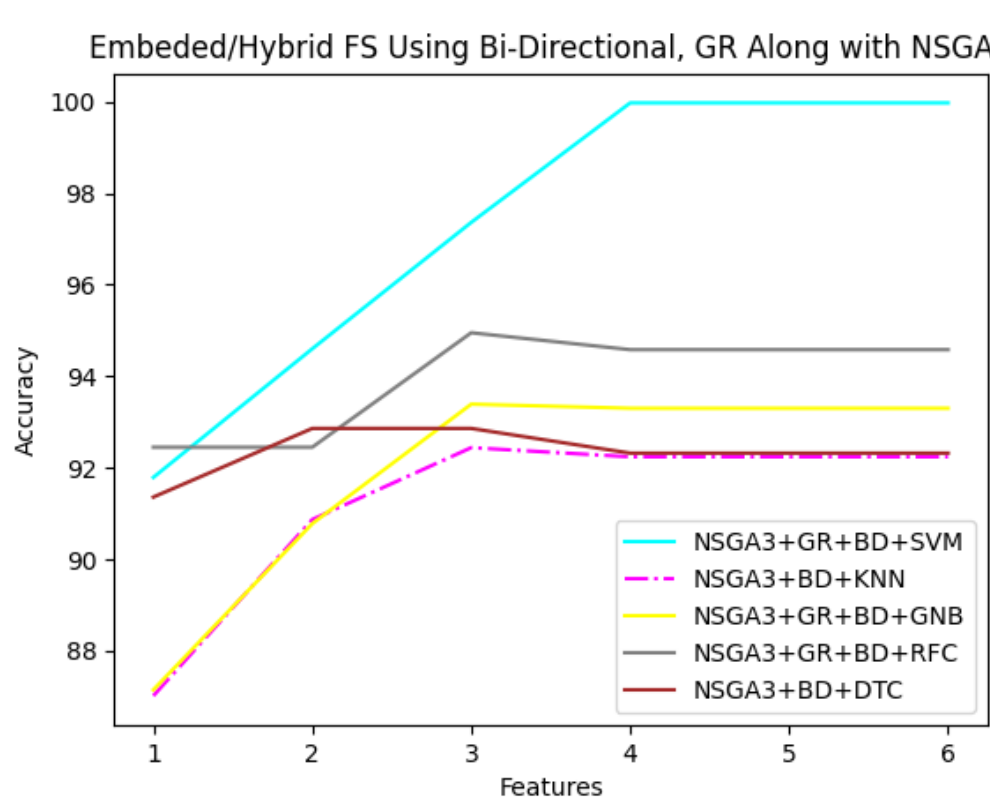
Figure 9. Hybrid NSGA3 + Bi-directional + GR feature selection performance.